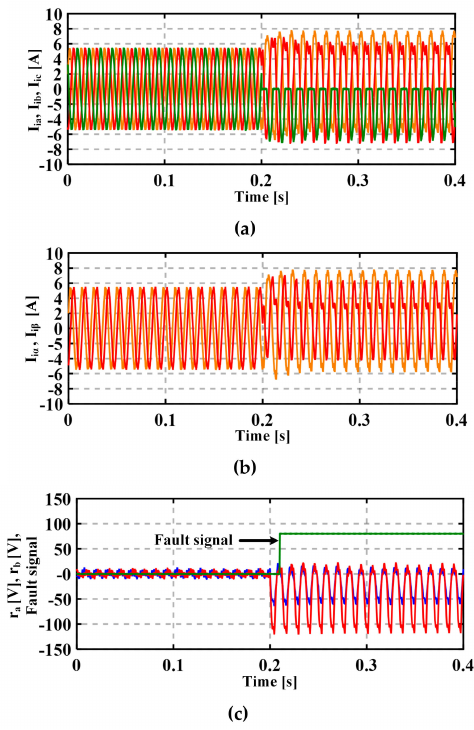
Figure 12. Experimental results: Open-switch fault on Q 5 at 0.2 s. ( a ) Filter currents of the three phases I ia (yellow), I ib (red), I ic (green); ( b ) filter currents in the stationary reference frame i i α (yellow), i i β (red); ( c ) residual errors r α (blue) r β (red), and fault signal (green).